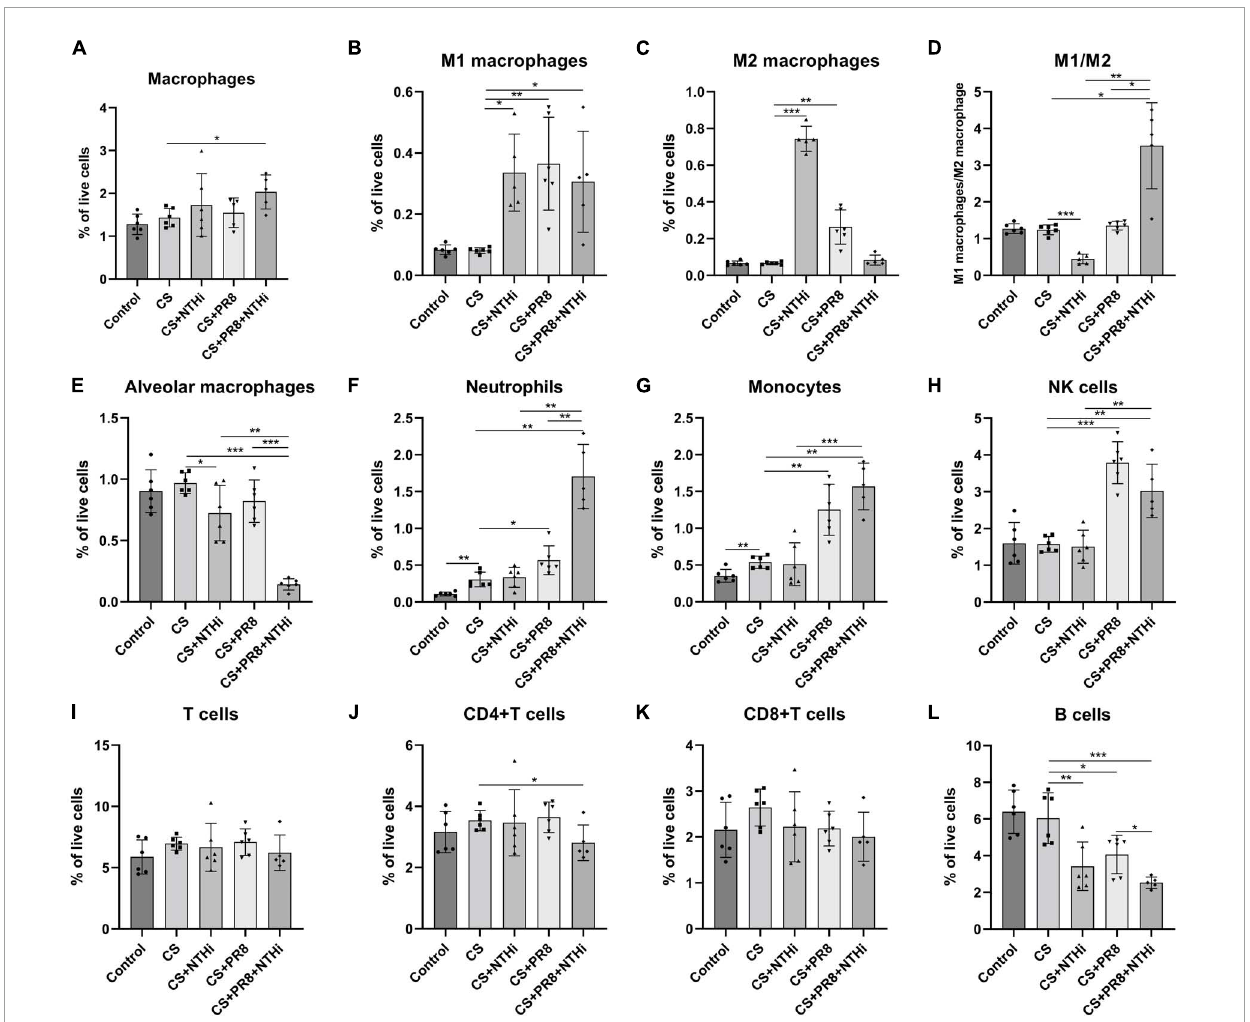
FIGURE8 Flow cytometric analysis of innate and adaptive immune cells in AECOPD mice lungs. Following digestion of lungs, the collected cells were analyzed by flow cytometry for monocyte-derived macrophages (A) , M1 macrophages (B) , M2 macrophages (C) , M1 macrophages to M2 macrophages ratio (D) , alveolar macrophages (E) , neutrophils (F) , monocytes (G) , NK cells (H) , T cells (I) , CD4 + T cells (J) , CD8 + T cells (K) , and B cells (L) . Data are expressed as mean ± SD ( n = 6). * p < 0.05, ** p < 0.01, and *** p <